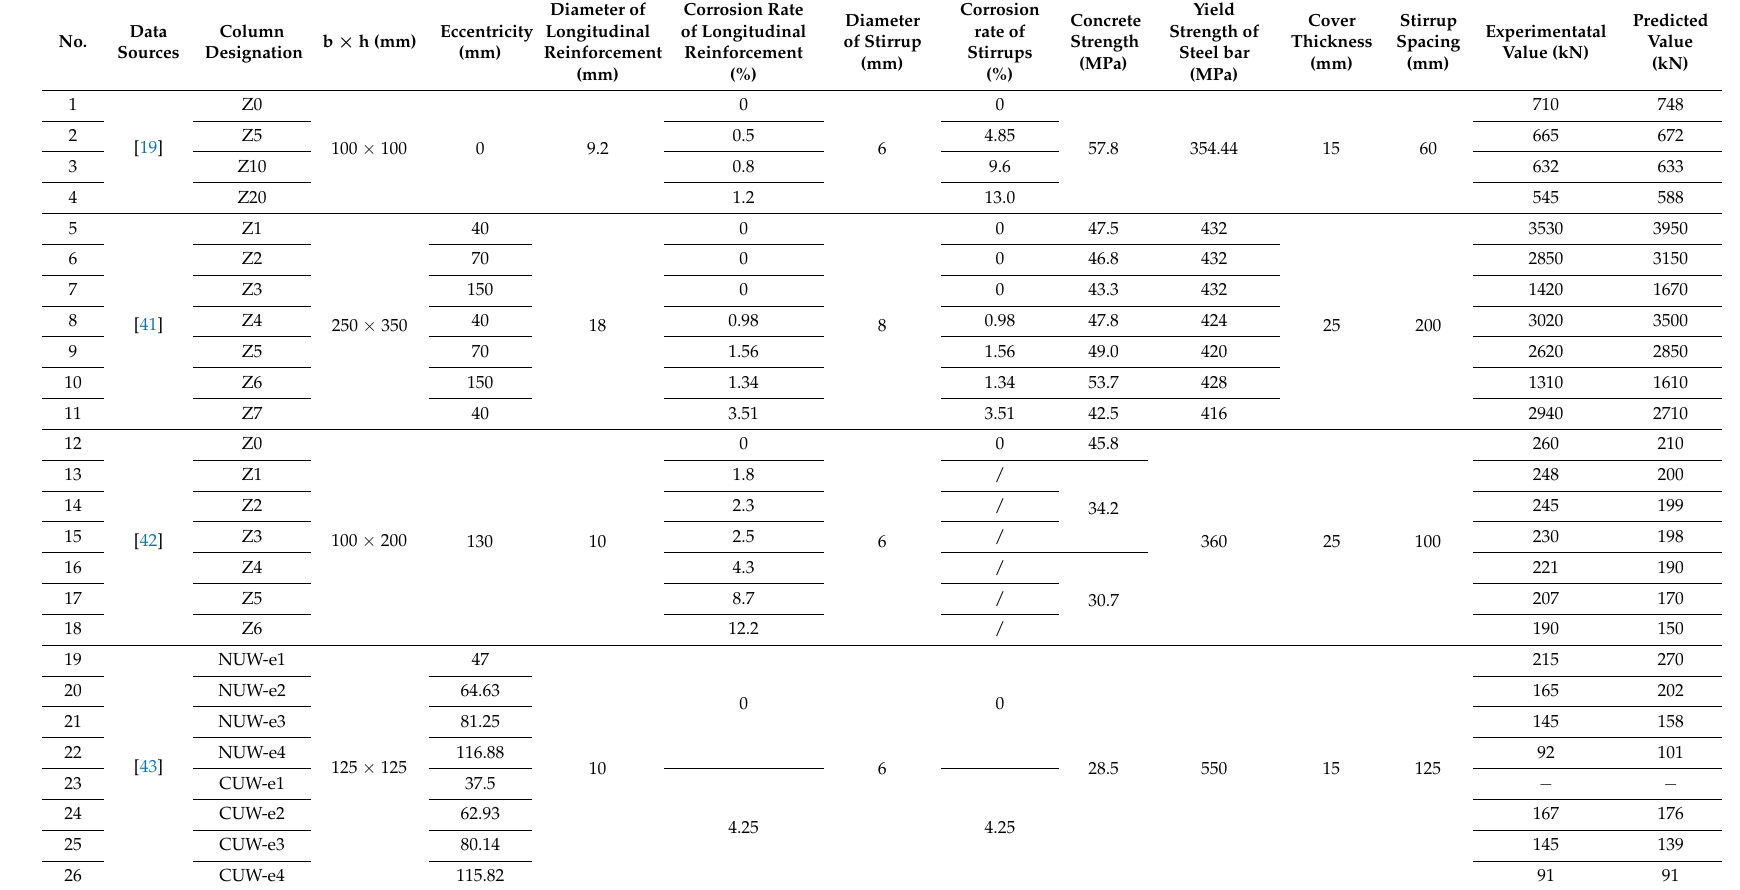
Table A1. The comparison between prediction results and experimental data in